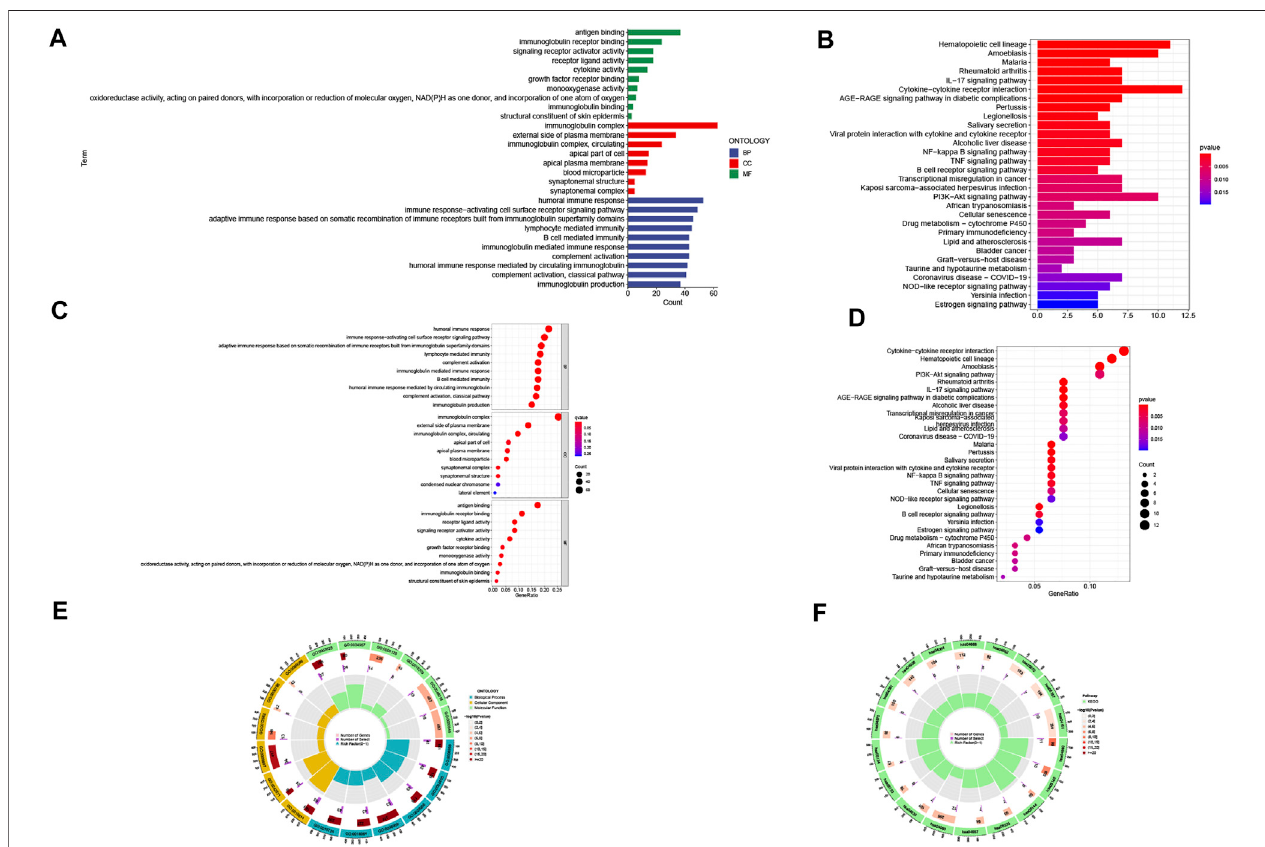
FIGURE 6 | Gene Ontology (GO) and Kyoto Encyclopedia of Genes and Genomes (KEGG) pathway enrichment analysis. (A) barplot of the top 10 GO enrichment terms. (B) barplotofthetop30KEGGenrichmentterms. (C) bubblechartofthetop10GOenrichmentterms. (D) bubblechartofthetop30KEGGenrichmentterms. (E) circle diagram of GO enrichment analysis. (F) circle diagram of KEGG enrichment analysis. Biological process, cellular component, and molecular function.